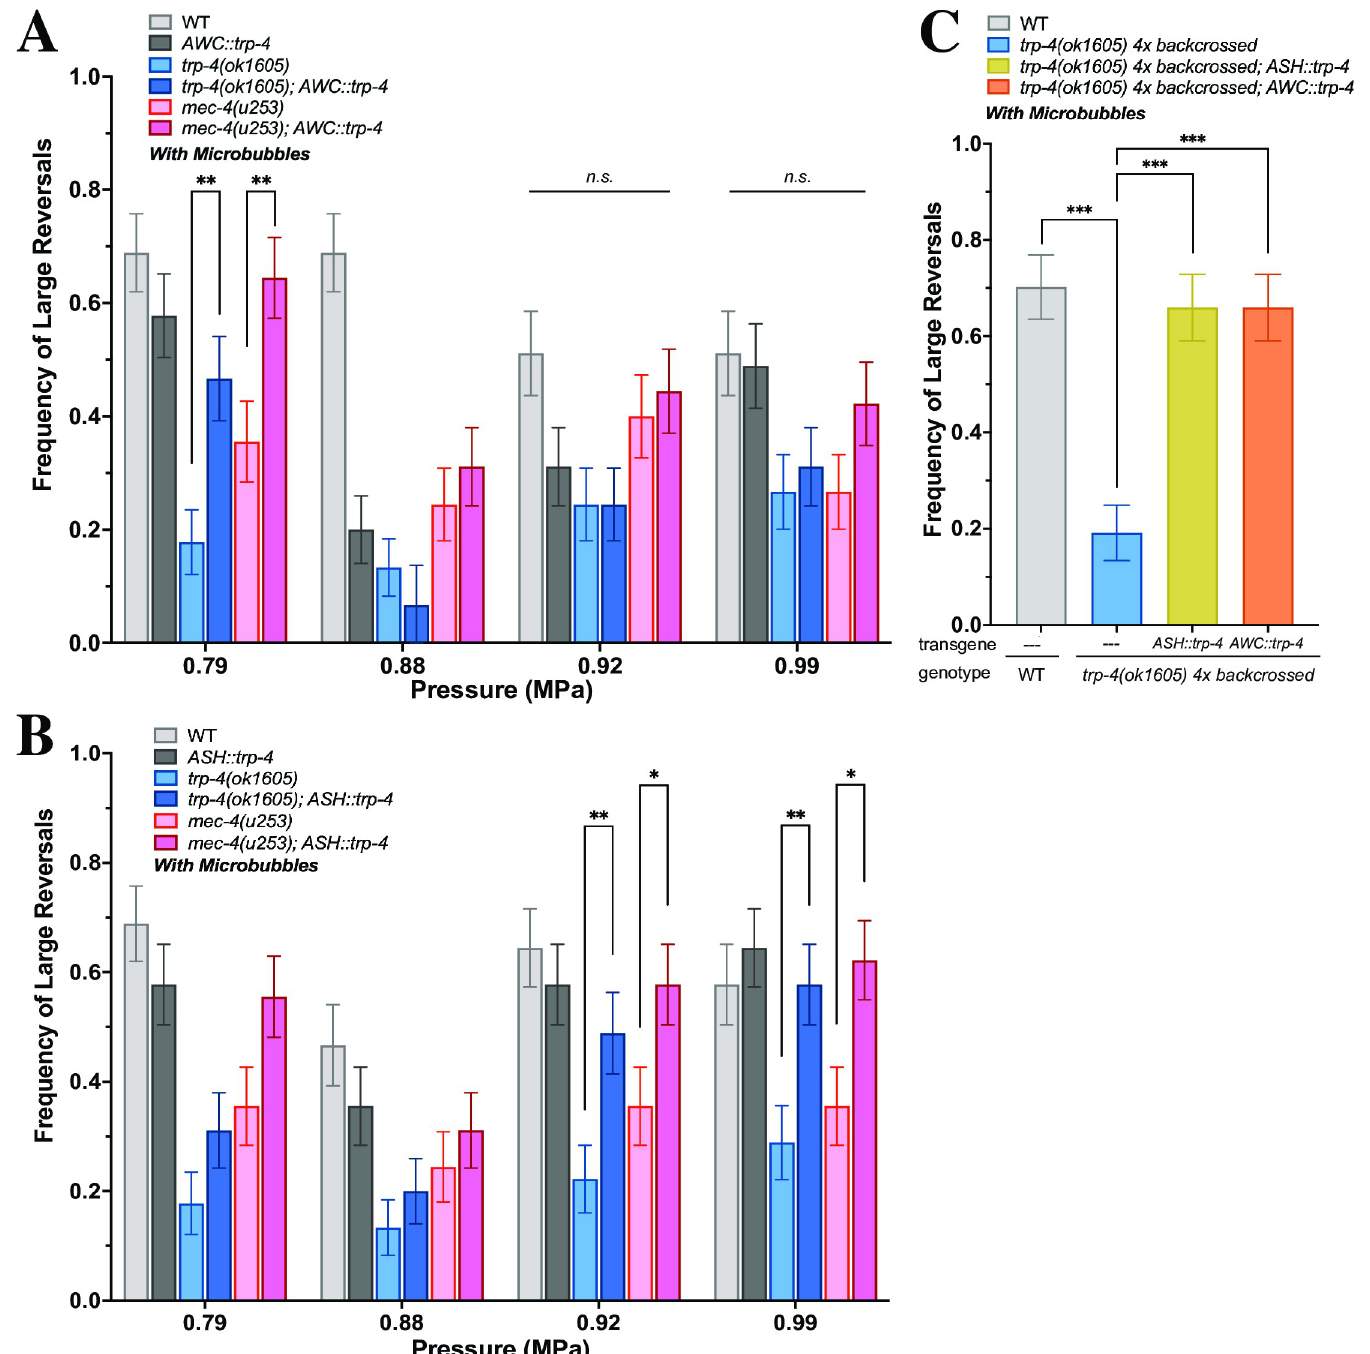
Fig 3. MEC-4 and TRP-4 act in parallel to mediate ultrasound-evoked behavioral changes. Frequency of large reversals (more than two head bends) in strains ectopically expressing TRP-4. Large reversal frequency with (A) AWC :: trp-4 and (B) ASH :: trp-4 in different backgrounds at different peak negative pressures are quantified. At certain conditions, trp-4 expression significantly increases large reversal frequency in both trp-4 knockout and mec-4 knockout animals. (C) At 0.99 MPa, TRP-4 expression in both ASH and AWC rescues large reversal behavior in the outcrossed trp-4(ok1605)4x mutant. n = 45 for each condition. Proportion of animals responding with standard error of the proportion are shown. ��� p < .001, �� p < .01, � p < .05 by two-proportion z-test.